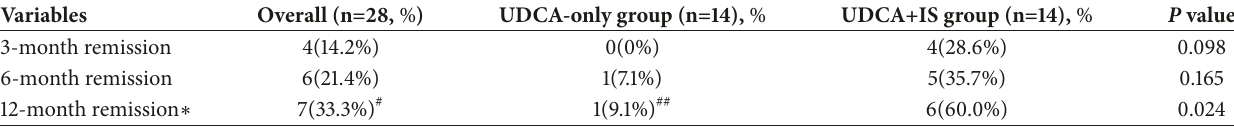
Table 4: Response to treatment in AIH features after 3, 6, and 12 months of therapy.